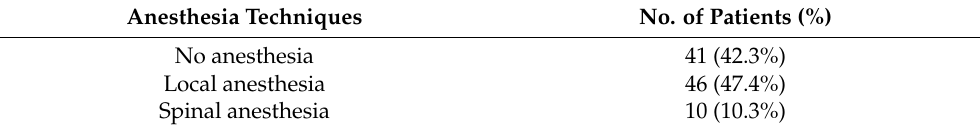
Table 2. Anesthesia techniques performed in the cohort of the 97 patients included in the